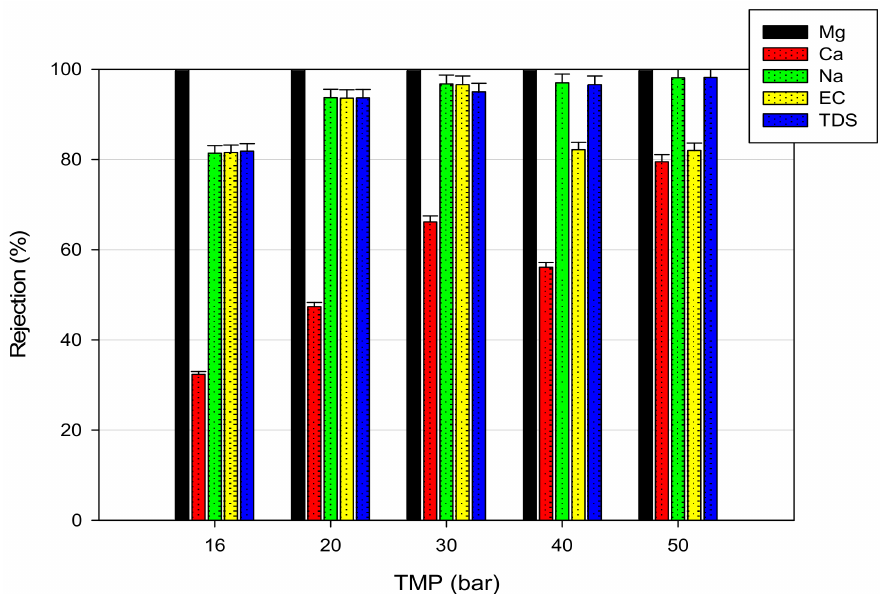
Figure 5. Rejection of SWC membrane towards ions, electrical conductivity (EC) and total dissolved solids (TDS) at different TMP